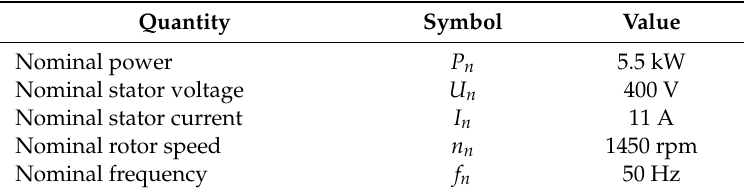
Table A1. Parameters of the induction